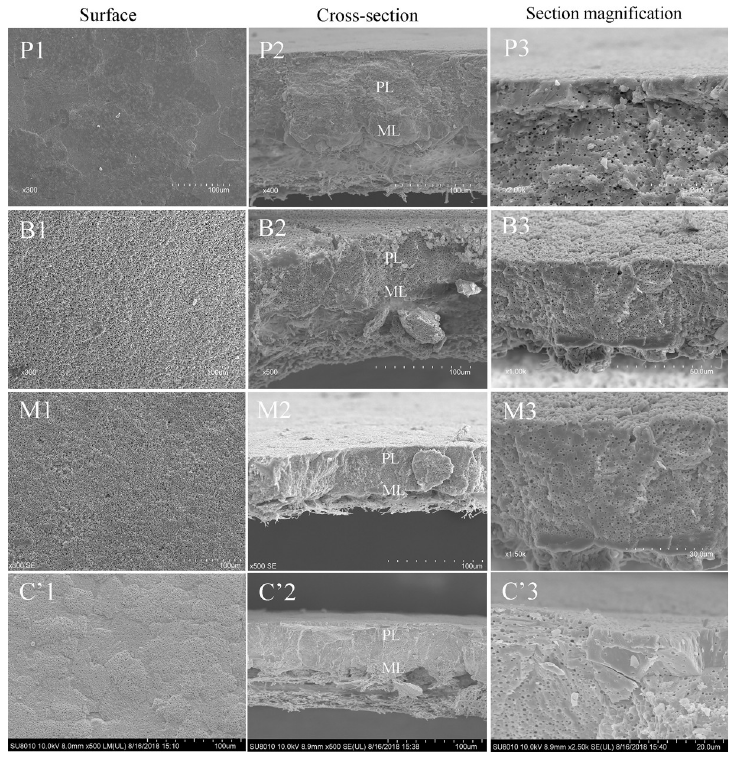
Fig 2. Eggshell surface and cross-section scanning electron micrographs of pigeon (P), budgerigar (B), munia (M), and canary (C’) eggs. The eggshell of pigeon, budgerigar, munia, and canary was divided into a mammillary layer (ML) and a palisade layer (PL). Budgerigar, munia, and canary eggs have many honeycomb vesicles in the organic matrix on the eggshell surface and in cross-section.